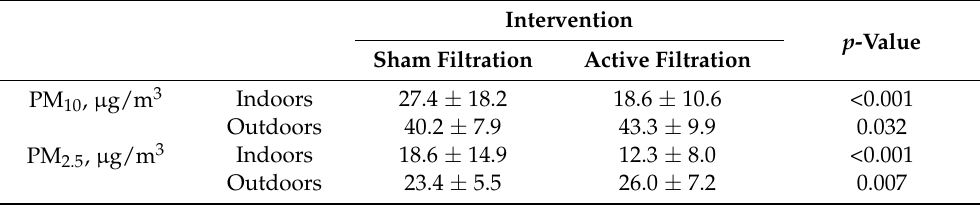
Table 2. Particulate matter concentration in indoor and outdoor environments during the interven- tion